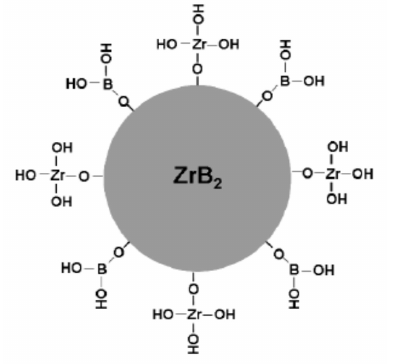
Figure 1. Corrosion and hydrolysis of the ZrB 2 particle in